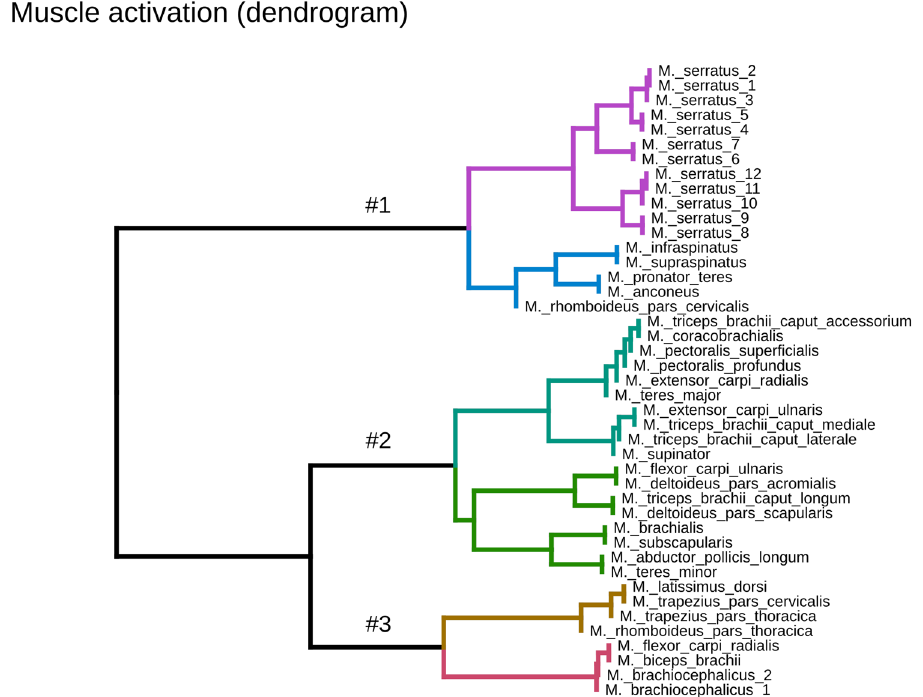
Figure 4. Hierarchical clustering (method—ward.d2) and minimal leaf sorting of simulated forelimb logarithmic muscle activation (log2) in the walking Beagle. The dendrogram shows how individual muscles were activated based on consecutive strides of the same trial. Groups represent a distance between activation patterns. The distance is displayed in the dendrogram as branch length. The longest lengths from the root were used as criteria to separate groups. The figure was created with the software package R 70